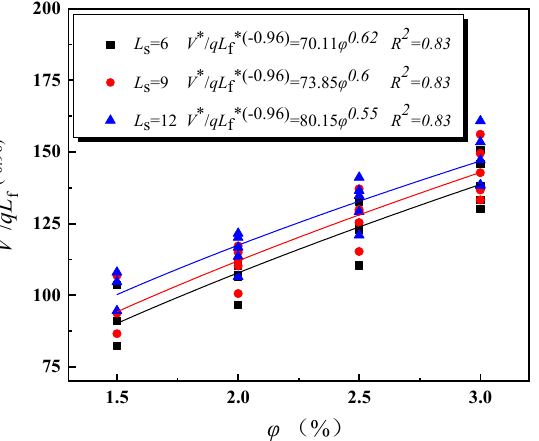
Figure 10. Dimensionless relationship between inlet air velocity and slope ( L f > 330 m). Substituting the simulation results into Equations (18) and (19), the dimensionless relationships between L s and inlet air velocity can be presented as Figures 11 and 12. As the height of the shaft increases, the inlet air velocity increases slowly. When L f ≤ 330, V ∗ is positively correlated with 4.42 + 0.138 ( L s ∗ ) 1.477 . When L f > 330, V ∗ is positively correlated with 71.06 + 1.40 ( L s ∗ ) 2.63 .